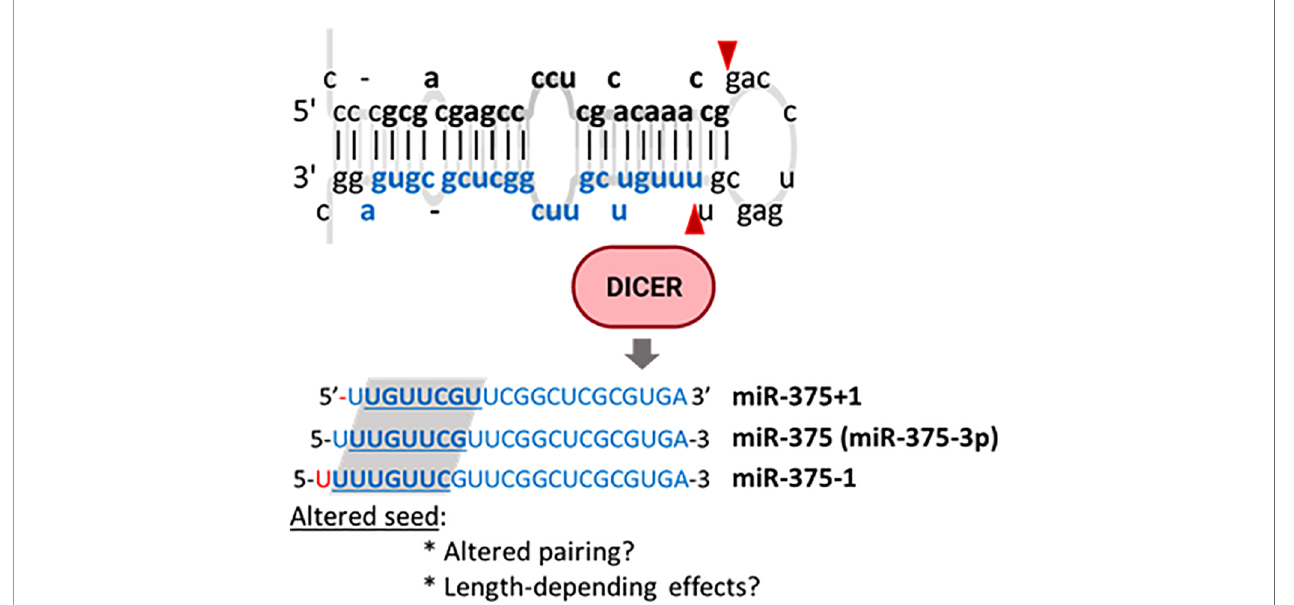
FIGURE 5 | MiR-375 isomiRs identi fi ed in pancreatic islets. Pre-miR-375 may be alternatively processed by Dicer to generate isoMiRs with one additional (miR-375-1) or one less (miR-375+1) nucleotide in the miRNA 5 ’ . These modi fi cations have the potential to alter target